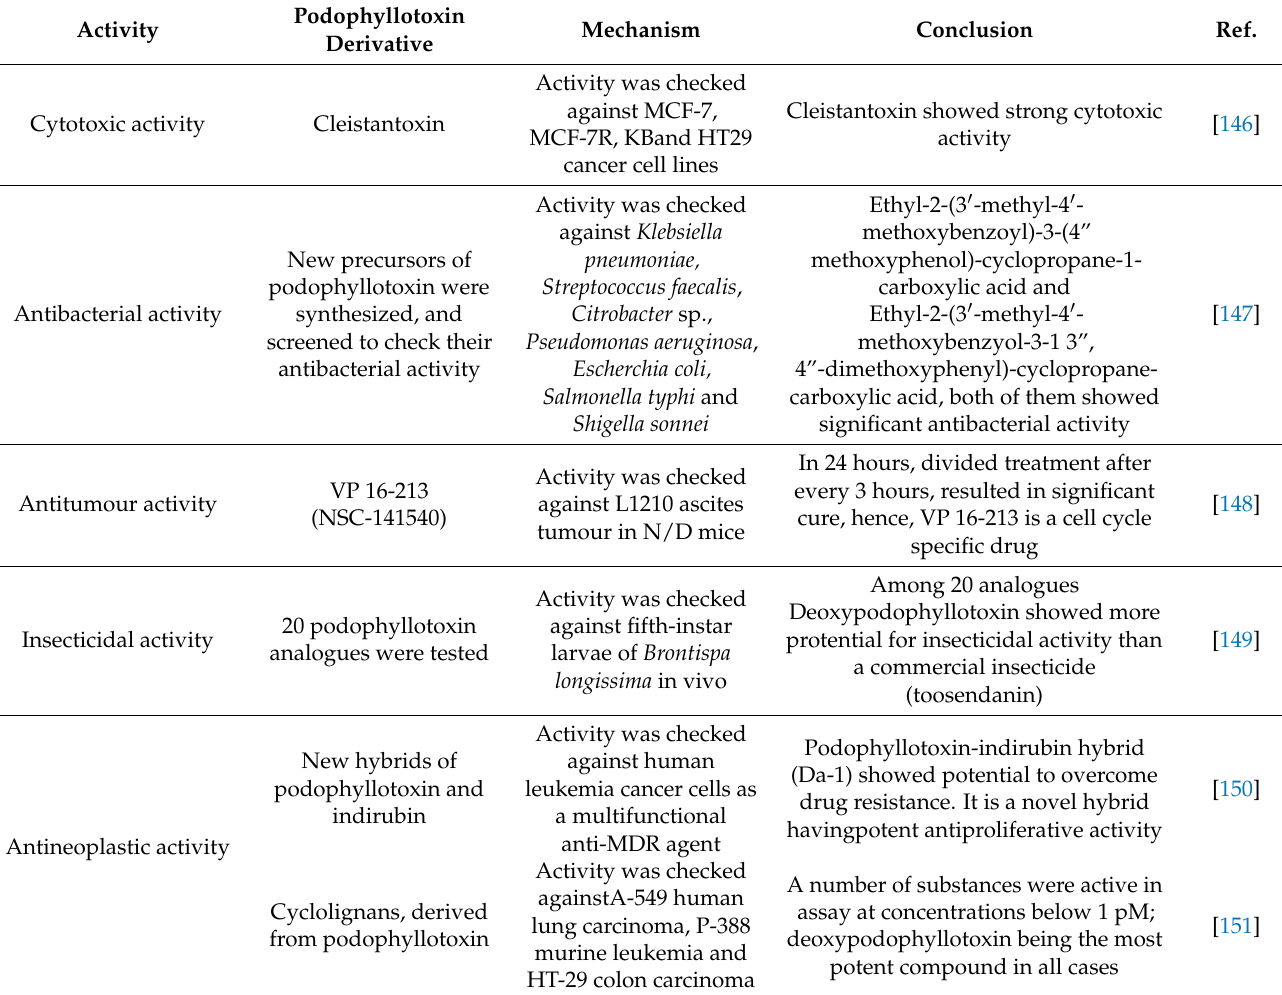
Table 4. Pharmacological activities of podophyllotoxin and its